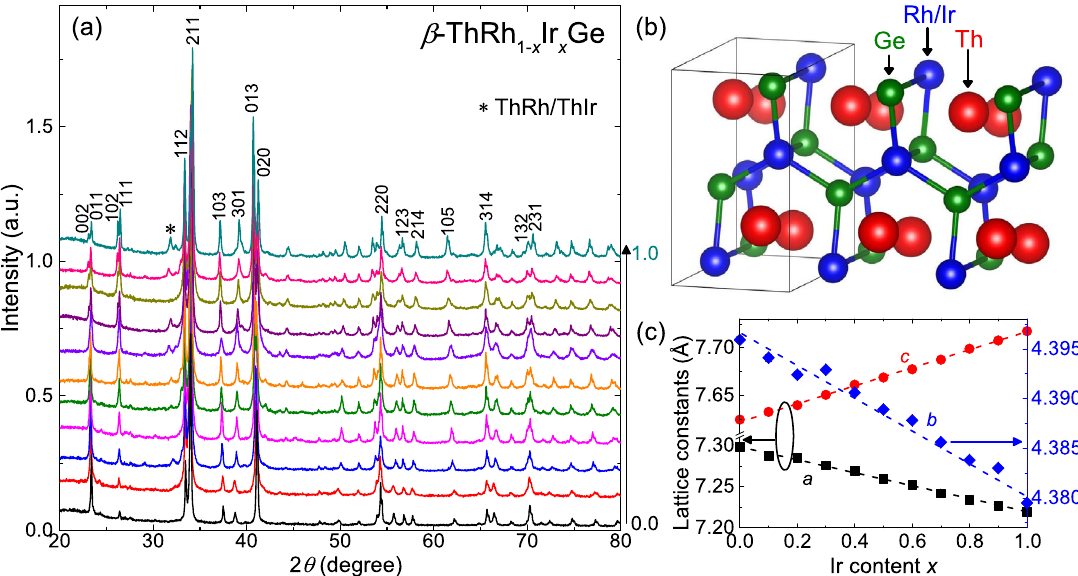
Fig. 1 X-ray diffraction results and schematic crystal structure of β -ThRh 1 − x Ir x Ge. a Room temperature XRD patterns for the series of polycrystalline β -ThRh 1 − x Ir x Ge samples. The diffraction peak due to the ThRh/ThIr impurity is marked by the asterisk. b Schematic structure of β -ThRh 1 − x Ir x Ge. The Th, Rh/Ir and Ge atoms are marked by the arrows. c Ir content x dependence of the orthorhombic lattice